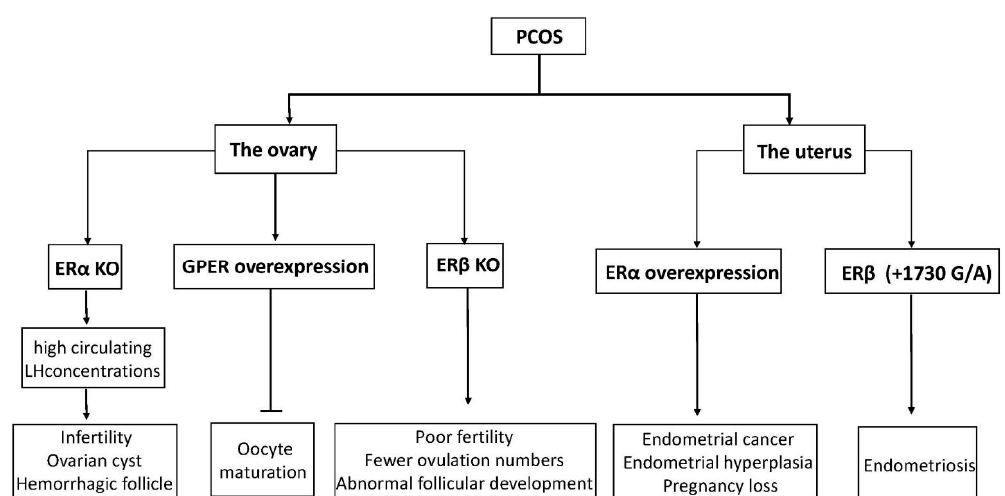
Figure 3. A diagram of physiological phenomena to explain disordered expression in the ER family. Arrows indicate direct effects, while no arrows indicate inhibition.